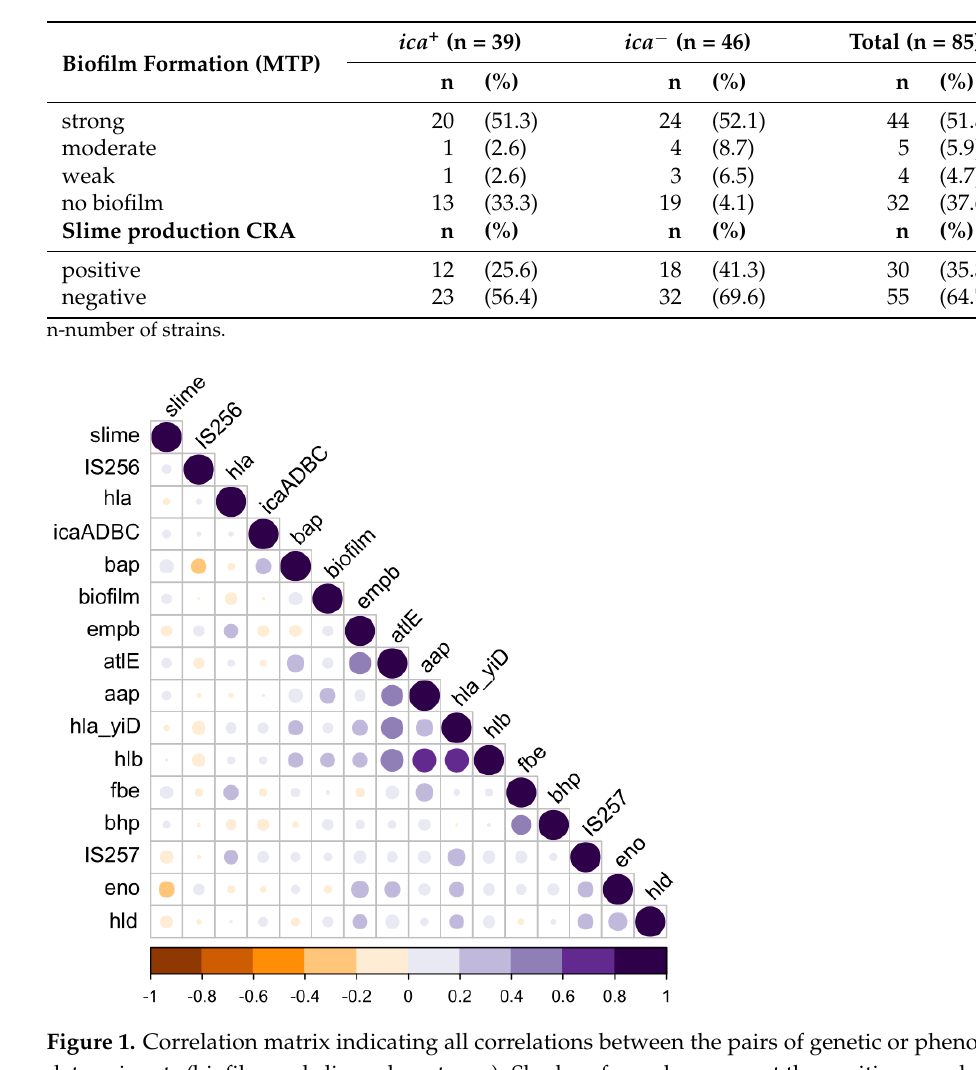
Table 2. Comparison of the ica operon detection and the biofilm and slime production within the CoNS strains.